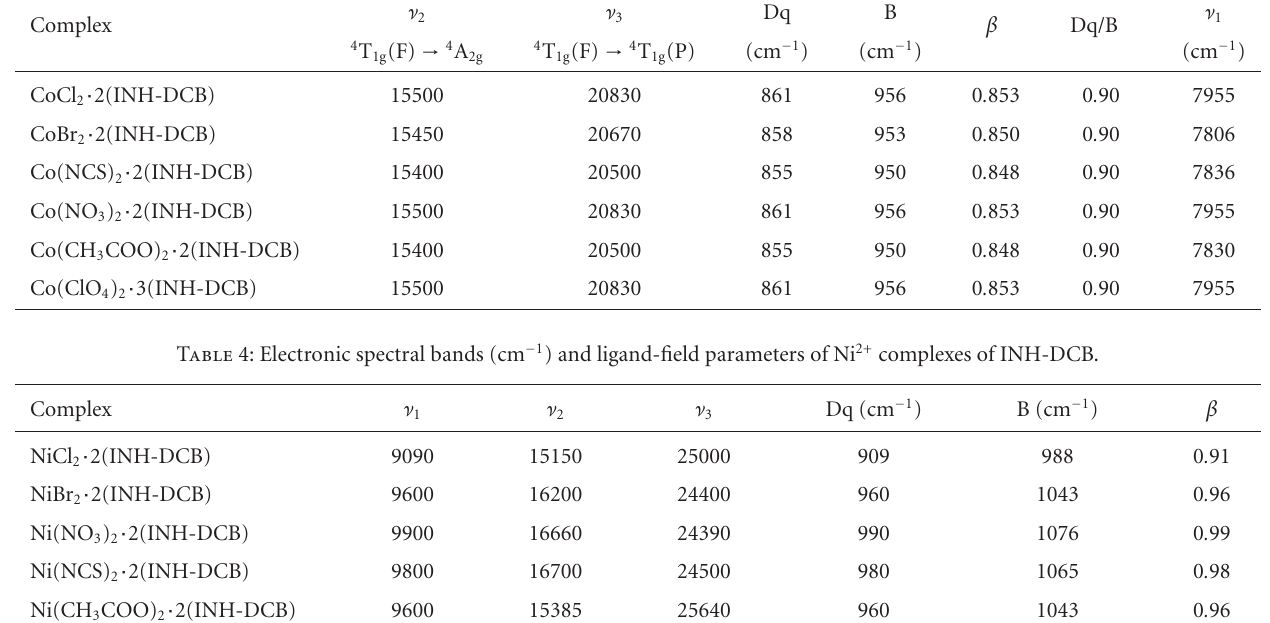
Table 3: Electronic spectral bands (cm − 1 ) and ligand-field parameters of Co 2+ complexes of INH-DCB. Complex